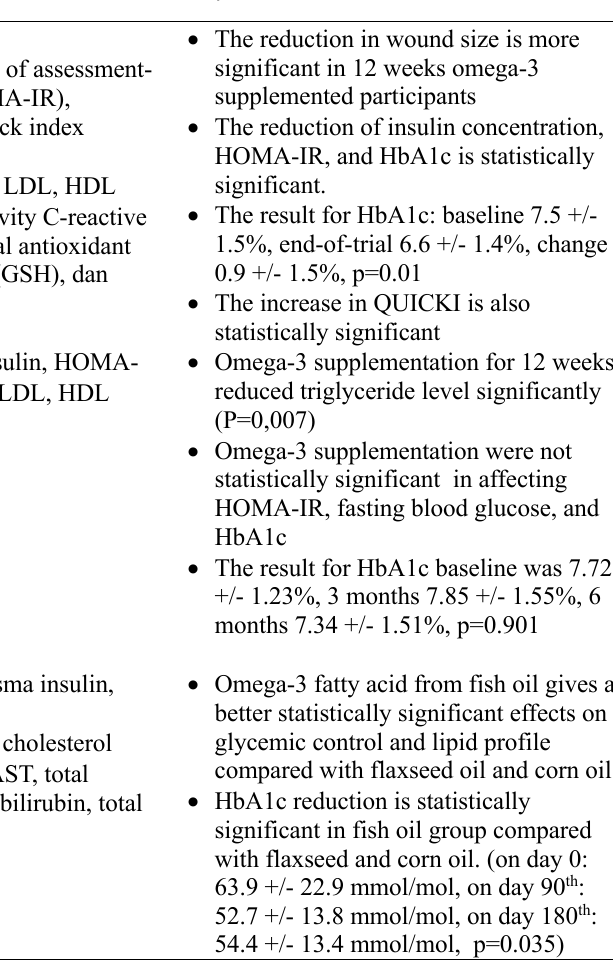
Table 5. Result of studies